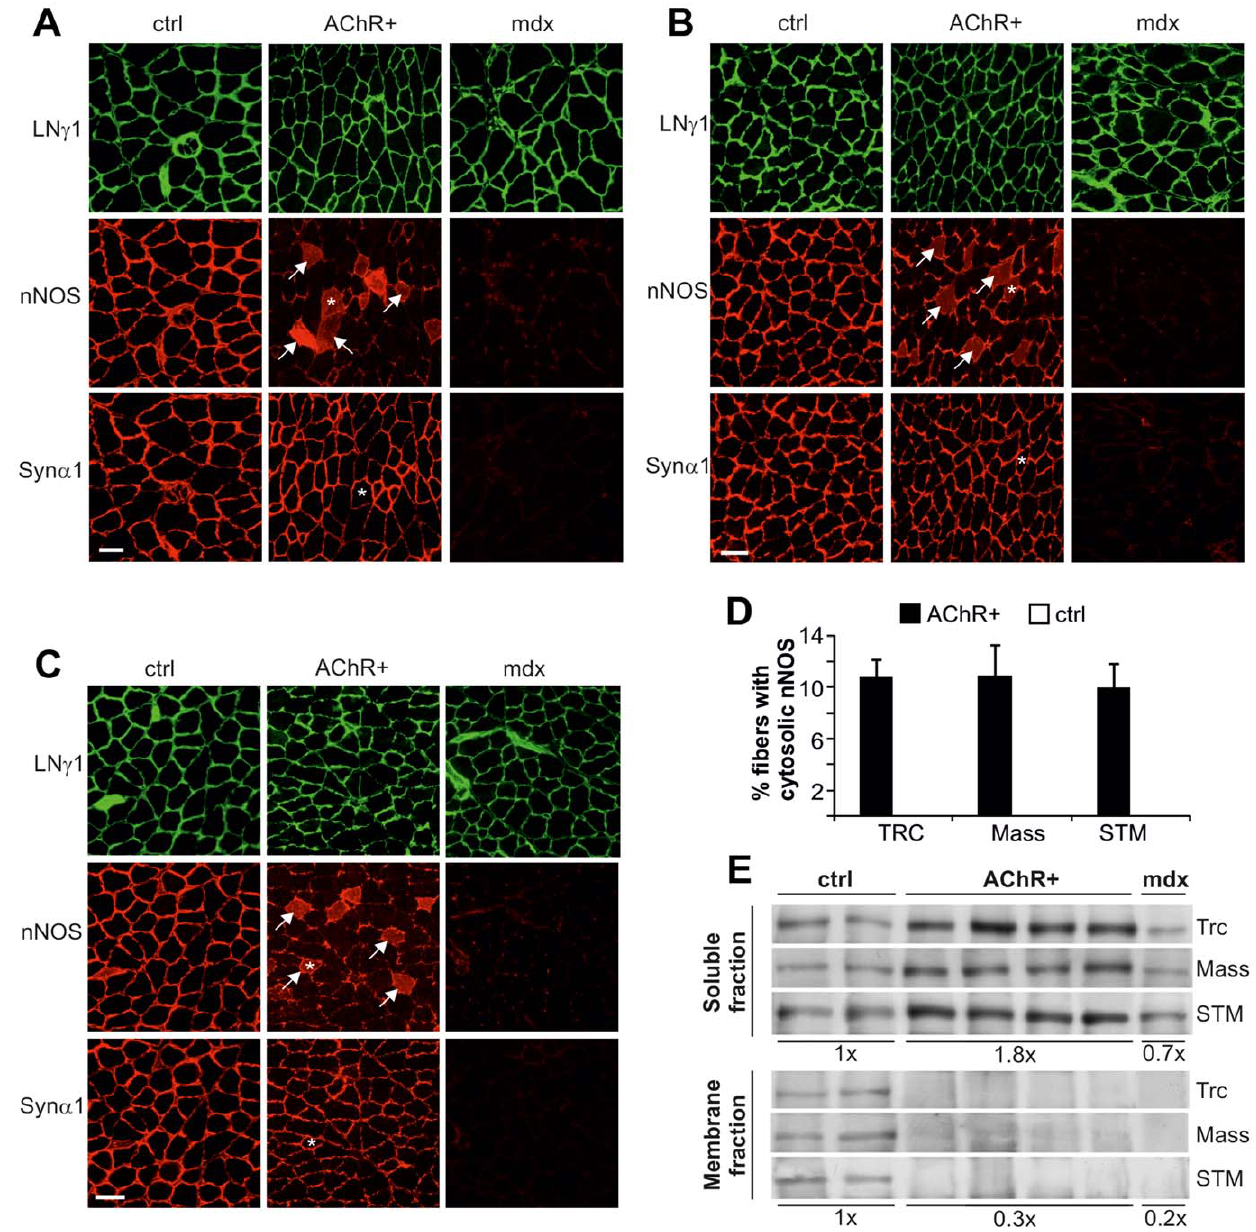
Figure 4. nNOS is lost from the sarcolemma and accumulates in the cytosol in muscles of EAMG mice. Immunostaining of cross-sections from (A) triceps, (B) masseter and (C) sternomastoid muscles with laminin- c 1 (LN c 1; first panels), nNOS (second panels) and syntrophin- a 1 (Syn a 1; third panels) antibodies. Representative images are shown. In contrast to CFA/PBS injected control mice (ctrl; n=3 for each muscle), sarcolemmal nNOS staining partially disappeared from the sarcolemma and was instead present in the cytosol (arrows) in AChR + EAMG muscles (AChR + ; n=4 for each muscle). Syntrophin a -1, the binding partner of nNOS, stably remained at the membrane. nNOS and syntrophin a -1 both were almost absent in mdx muscles (n=2 for each muscle). Asterisks indicate identical fibers in consecutive sections. (D) 10–11% of the fibers in AChR + EAMG muscles were positive for cytosolic nNOS staining, whereas no such fiber was found in control muscles. (E) Western blot analysis of the nNOS protein levels present in the soluble (cytosol; upper panel) and the membrane (sarcolemma; lower panel) protein fraction of triceps (Trc), masseter (Mass) and sternomastoid (STM) muscles. Representative bands are shown. nNOS levels were increased in the soluble fraction of muscles from AChR + EAMG mice (AChR + ; n=6) with approximately 80% when compared to muscles from CFA/PBS injected control mice (ctrl; n=4). In mdx mice (n=3), approximately 70% of nNOS protein remained in the cytosol. In the membrane fraction, indicating sarcolemmal position, nNOS was reduced to 30% of control values in AChR + EAMG mouse muscles and to 20% in mdx muscles. Scale bars =50 m m. doi:10.1371/journal.pone.0044148.g004 (Fig. 5F). In summary, denervation marker and atrophy factors stained EAMG muscle cross-sections (Fig. 5E) and a quantitative evaluation of the fiber size distribution confirmed the shift to were up regulated and muscle fiber atrophy was evident in all smaller fibers in AChR + EAMG compared to control muscles examined muscles of EAMG mice.